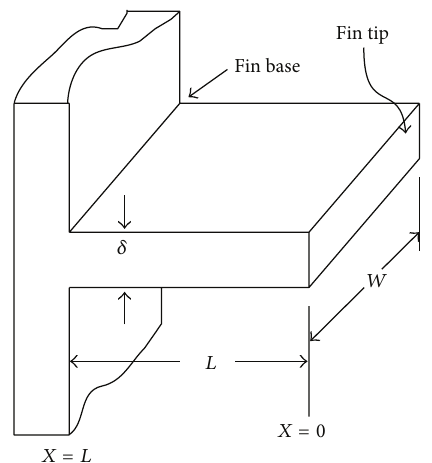
Figure 1: Schematic representation of a longitudinal fin with a rectangular